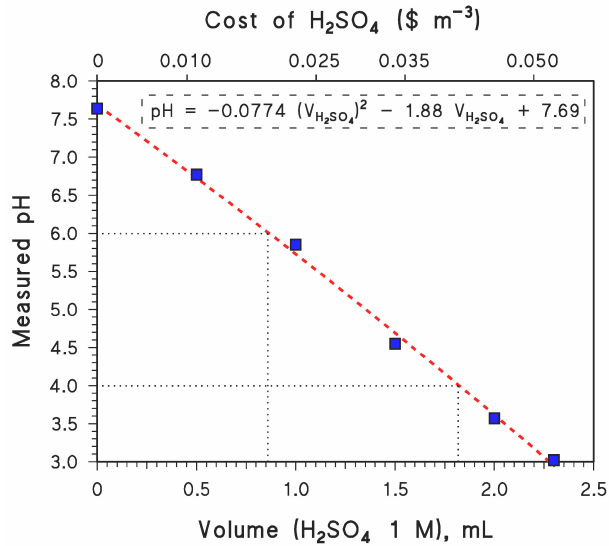
Figure 5. Results of tap-water titration with H 2 SO 4 (measured pH, as a function of added volume of H 2 SO 4 1 M). The upper X -axis plots the cost of H 2 SO 4 addition, based on an estimate of USD 240 (ton H 2 SO 4 ) − 1 [46]. The reported phenomenological equation is a second-order polynomial fit. The volumes of H 2 SO 4 needed to bring the pH to values of 4 and 6 are highlighted. (The latter allows for the calculation of the amount of CaO needed to fix the pH at 6 at the end of the